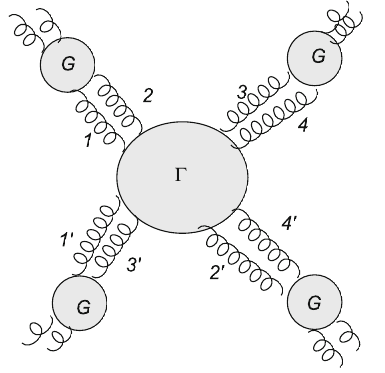
Fig. 6 Four pomerons coupled with the quadruple vertex